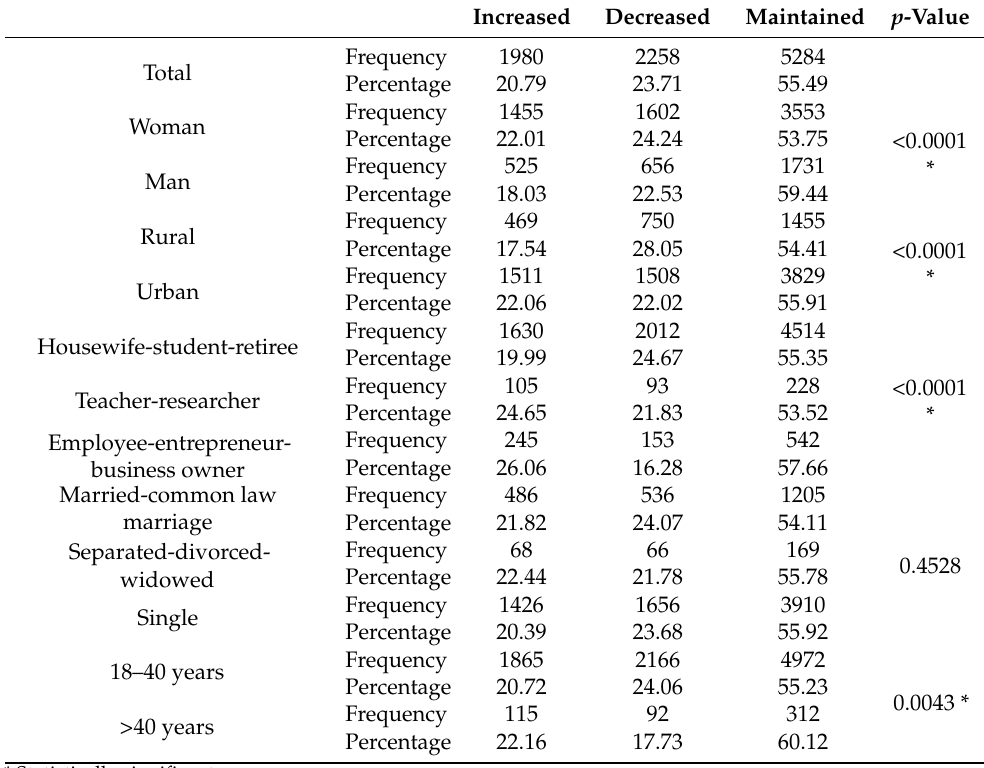
Table 4. Changes in habitual food intake; total population, and by demographic characteristics.